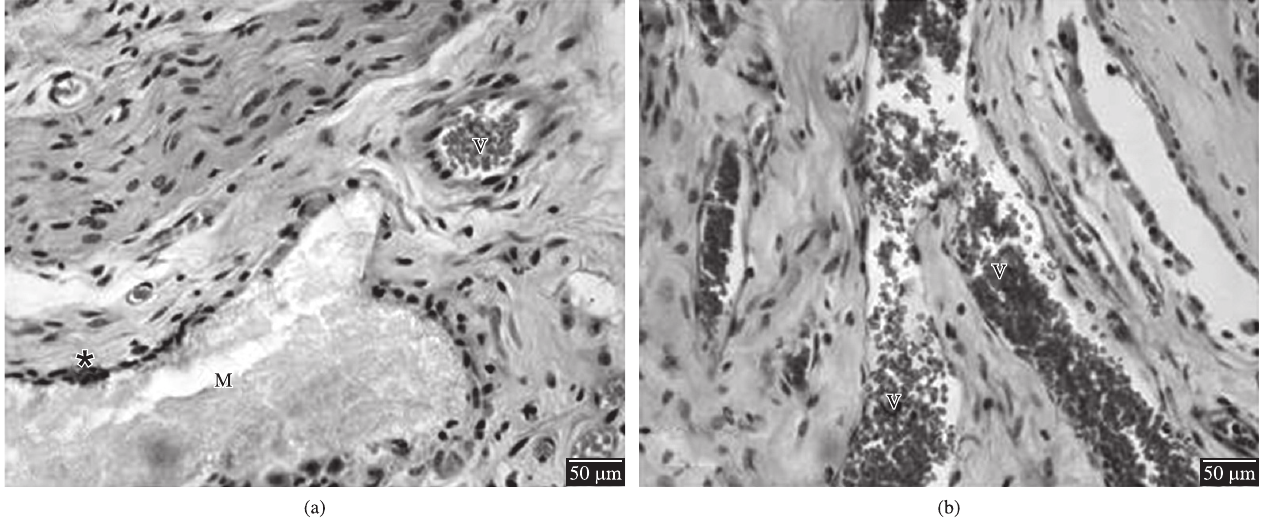
Figure 3. Histological sections, stained with HE, 28 days after grafting with HA (a) or ZnHA (b). Asterisks indicate Multinucleated Giant Cells. (M) indicates the grafted area. (V) indicates blood